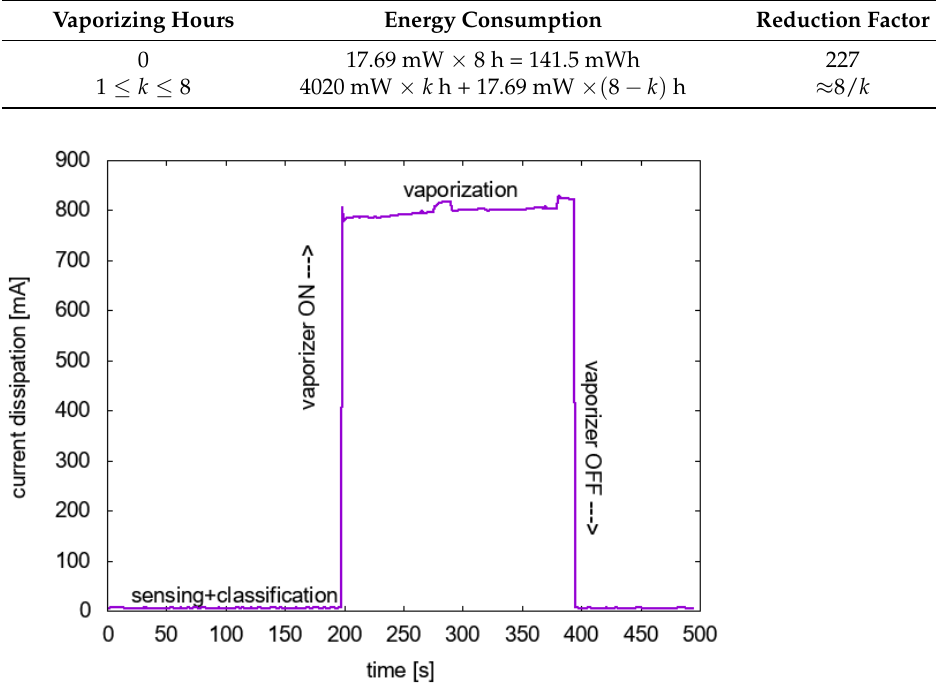
Table 8. Energy consumption of the proposed system.